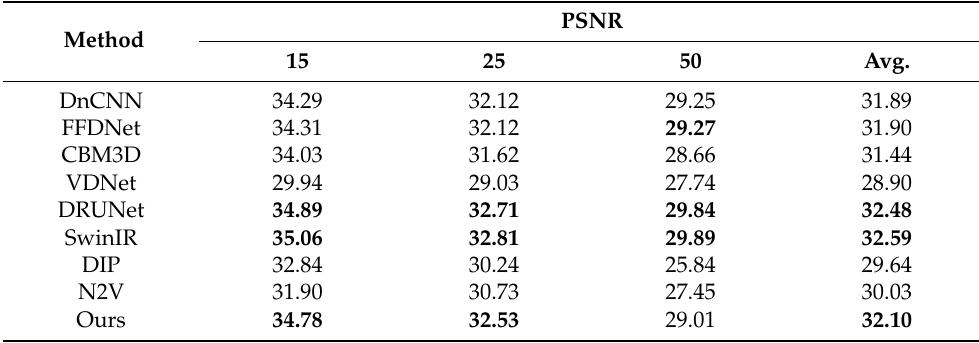
Table 5. Comparison of the averaged PSNR (dB) of different methods on the Set5 dataset. The best three performances are highlighted in